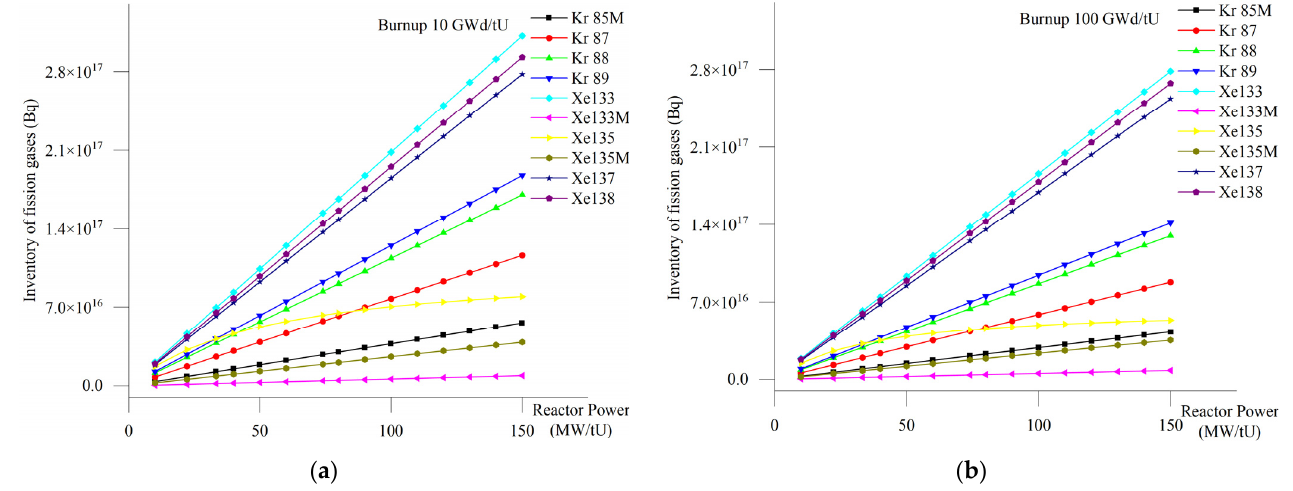
Figure 9. Inventories of fission gas nuclides with various reactor powers under fixed burnup: ( a ) 10 and ( b ) 100 GWd/tU.